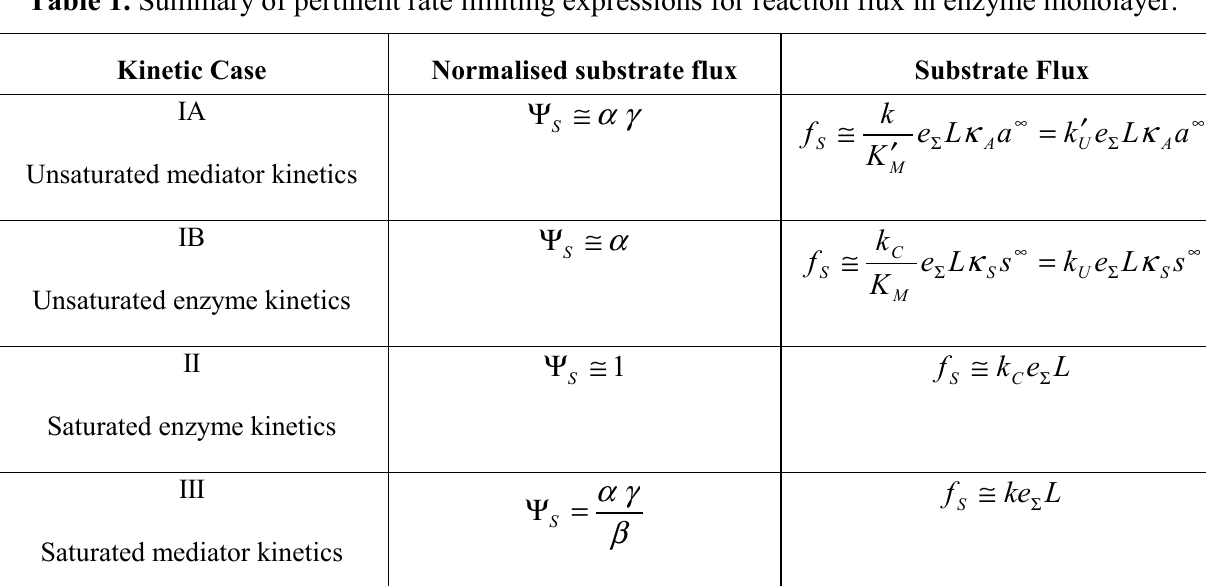
Figure 3. Kinetic case diagram for an immobilized enzyme monolayer system. Table 1. Summary of pertinent rate limiting expressions for reaction flux in enzyme